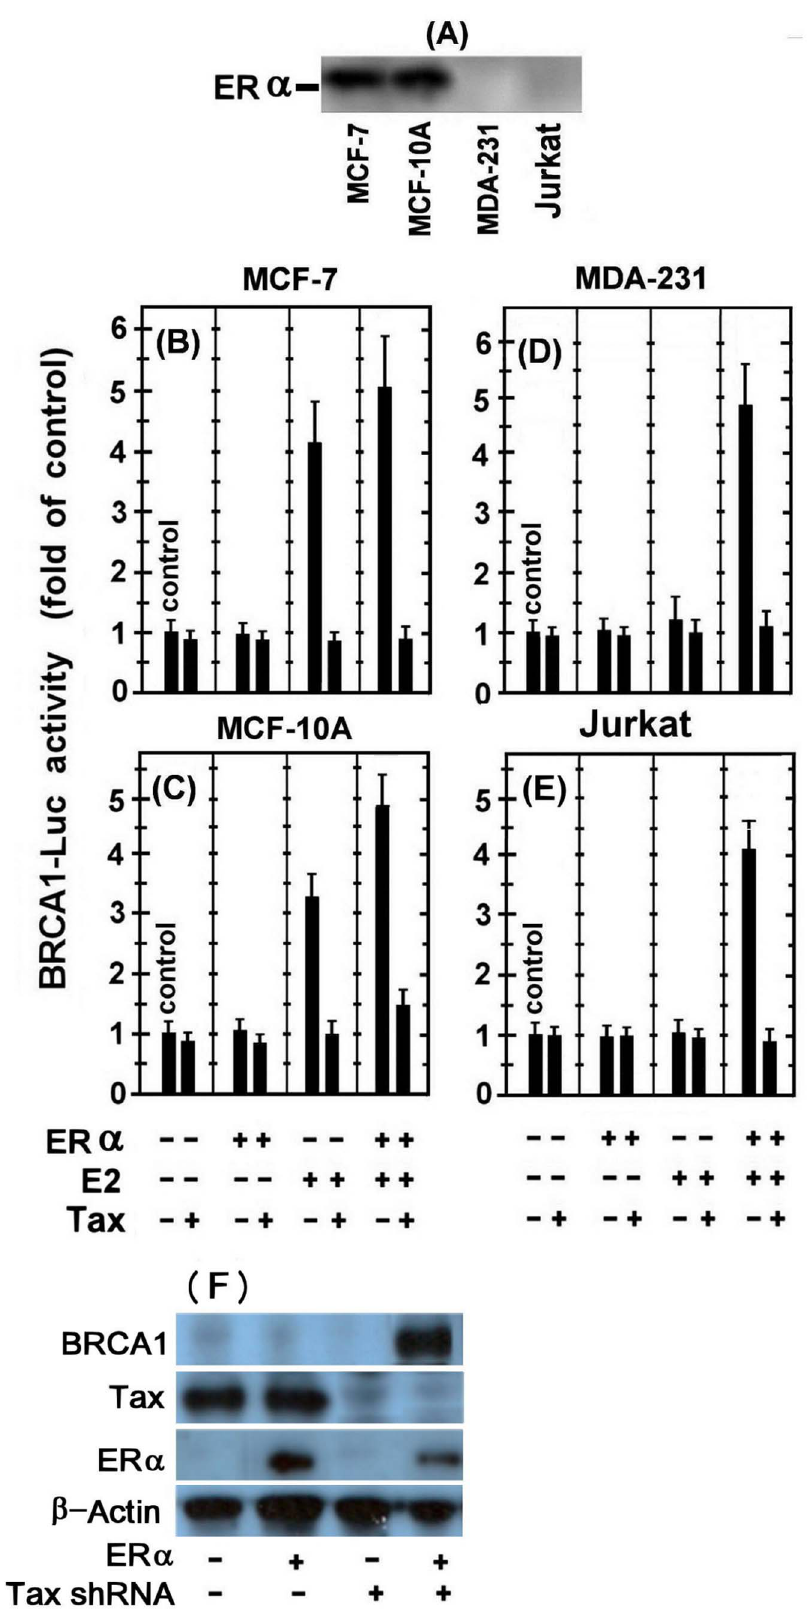
Figure 3. Effect of Tax on the non-classical pathway of E2-ER a induced BRCA1 expression. Western blot analysis of the whole cell extracts of the examined cell lines with anti ER a monoclonal antibody. MCF-7 (B), MCF-10A (C), MDA-231 (D) and Jurkat (E) cells were transfected with either